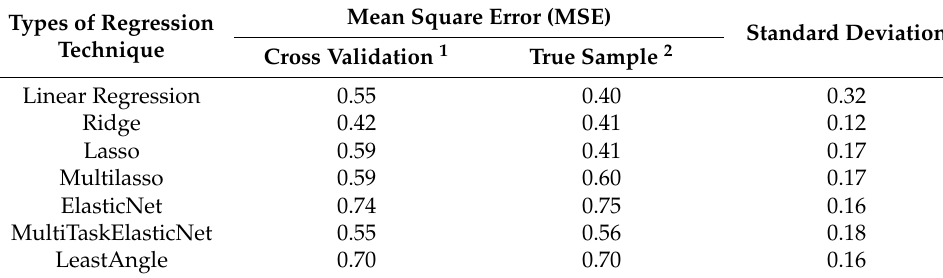
Table 4. Comparative Analysis of Regression Models.